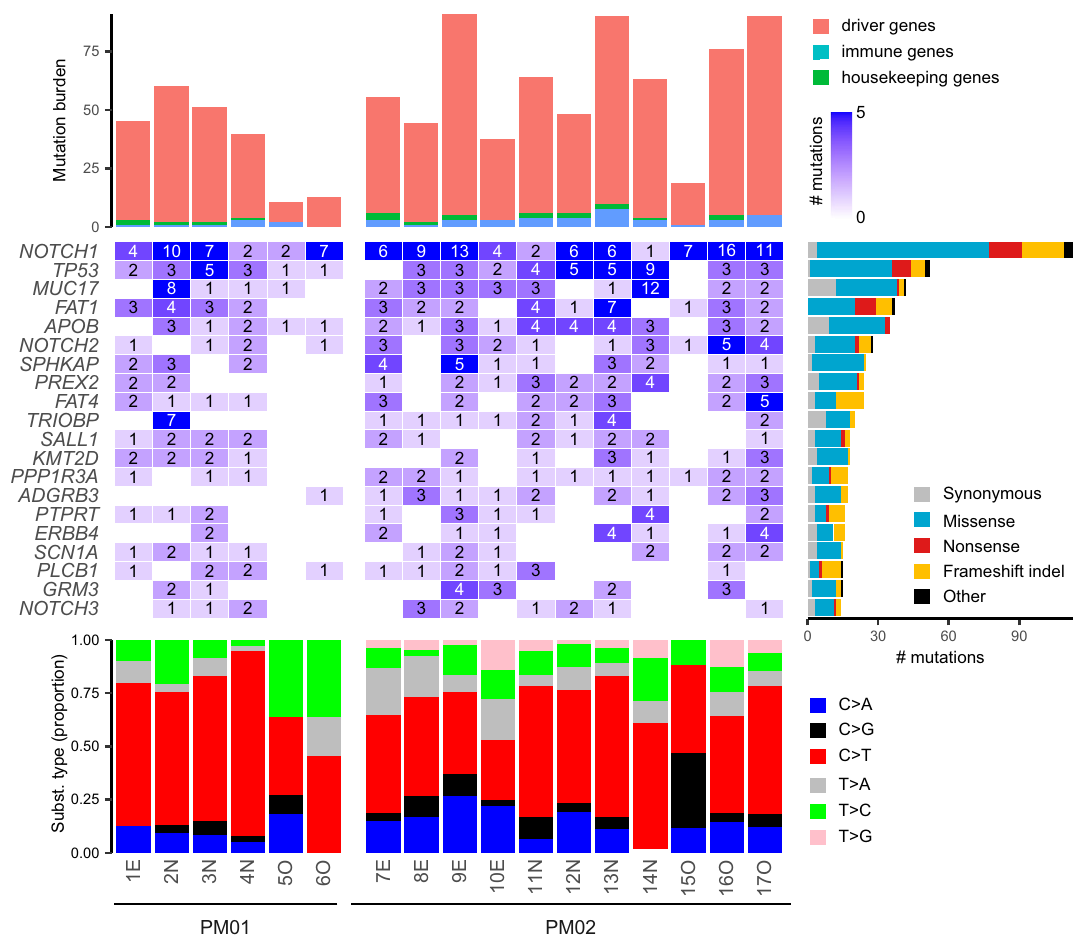
Figure 2. Characterization of somatic mutations in epidermal skin and oral epithelia. Somatic mutations were called from deep (1000 ×) targeted sequencing. The 20 most frequently mutated genes with indication of the number of identified mutations per sample are shown in the middle plot. Genes are ranked from top to bottom following mutation frequency, as indicated by the right bar. Upper plot shows the mutation burden, stacked according to the type of gene (driver gene, immune gene or housekeeping gene, as indicated). Bottom plot shows the distribution of the 6 main substitution types in each sample. Sample and patient pseudo-identifiers indicated on the bottom. E, epidermal eyelid sample; N, epidermal nose sample; O, oral